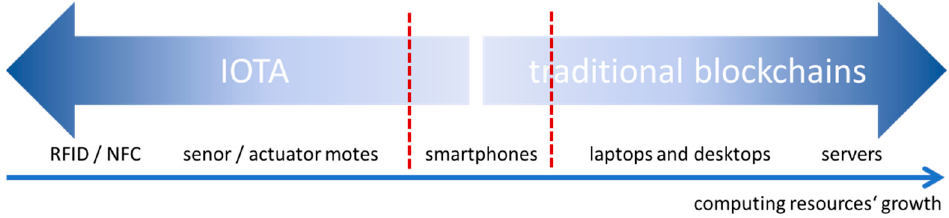
Figure 4. Positioning smartphones with respect to their computing resources for supporting DLTs.